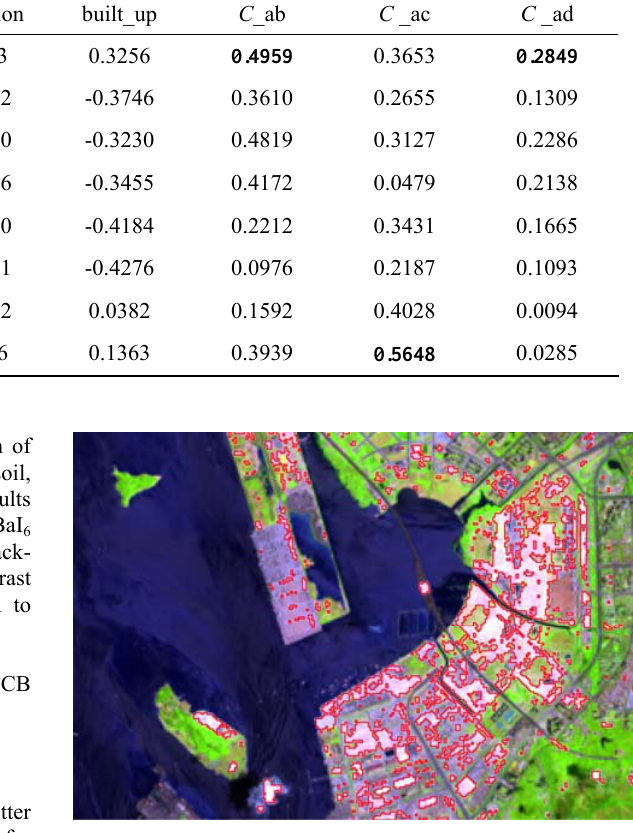
Figure 5. The BI results of study